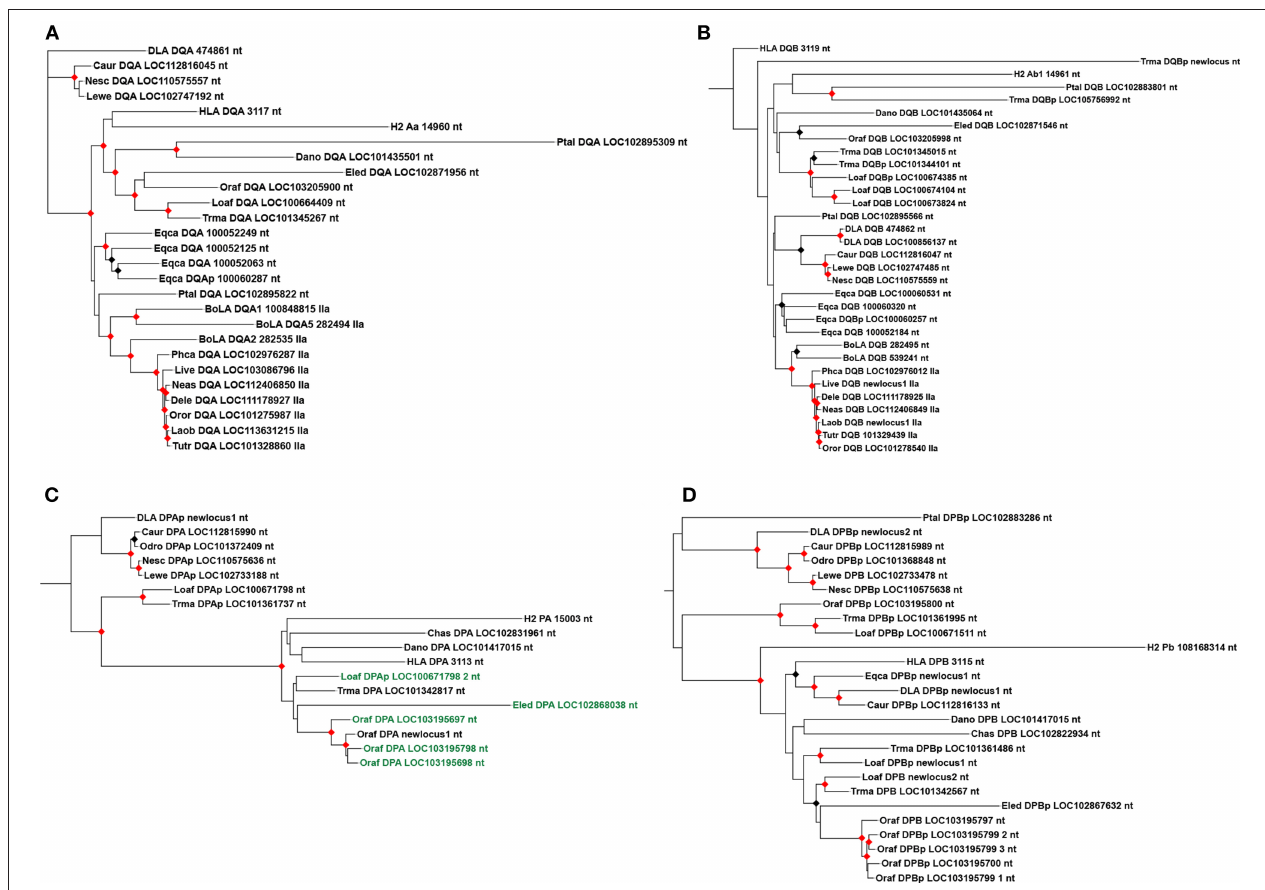
FIGURE 6 | Maximum likelihood phylogenetic trees of DQ and DP MHC class II genes and pseudogenes. (A) DQA introns 1, 2, and 3 phylogeny; (B) DQB introns 1, 2, 3, 4, and 5 phylogeny; (C) DPA introns 1, 2, and 3 phylogeny; (D) DPB introns 1, 2, 3, and 4 phylogeny. In (C) , sequences with a 3-codon insertion on exon 3 are in green. “p” refers to pseudogenes. Black and red circles indicates > 80 and > 95% support values, respectively. L. africana , Loaf; T. manatus , Trma; O. afer , Oraf; El edwardii , Eled; C. asiatica , Chas; E. telfairi , Ecte; D. novemcintus , Dano; B. acutorostrata , Baac; D. leucas ; Dele; L. vexillifer , Live; N. asiaeorientalis , Neas; O. orca , Oror; L. obliquidens , Laob; T. truncates , Tutr; P. catodon , Phca; C. ursinus , Caur; N. schauinslandi , Nesc; L. weddelli , Lewe; O. rosmarus , Odro; P. alecto , Ptal; E. caballus , Eqca; B. taurus , BoLA; H. sapiens , HLA; M. musculus , H2; C. l. familiaris ,